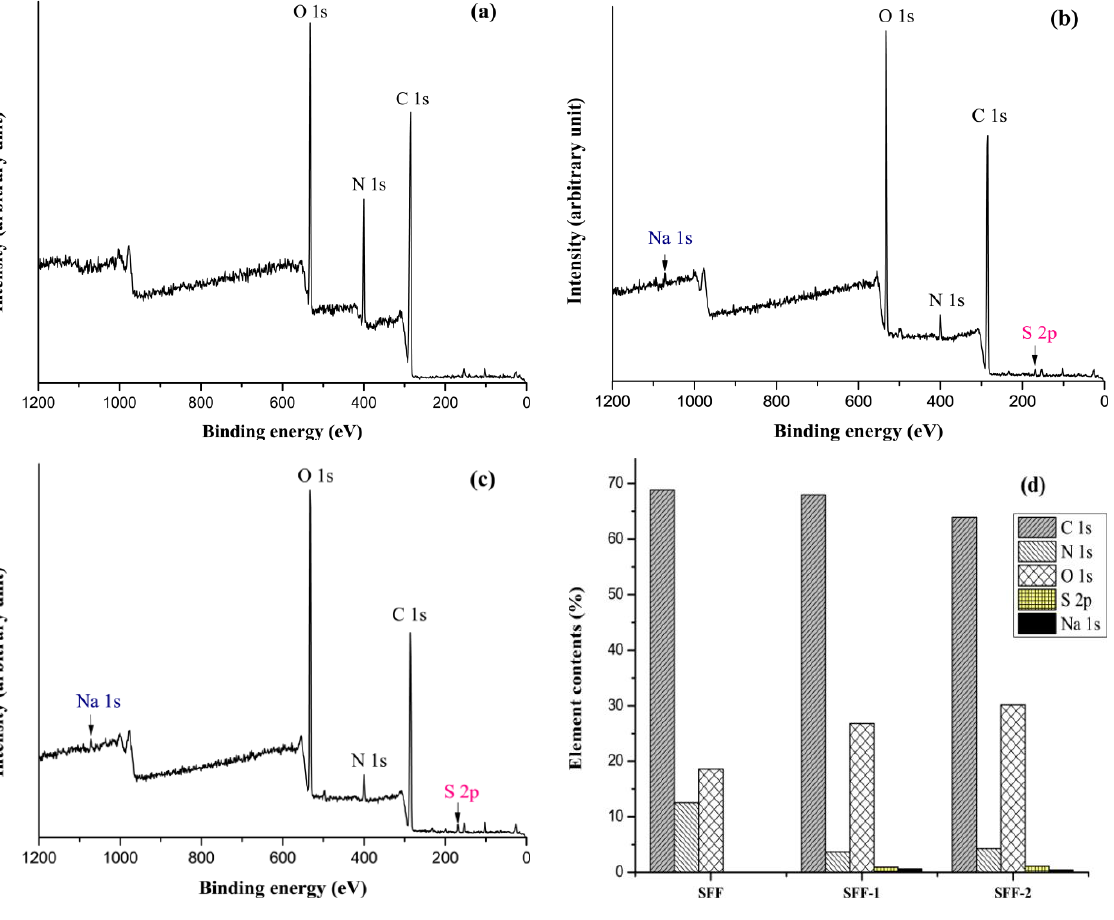
Figure 6. XPS spectra of ( a ) SFF ( b ) SFF-1 and ( c ) SFF-2 and ( d ) relative elemental contents.